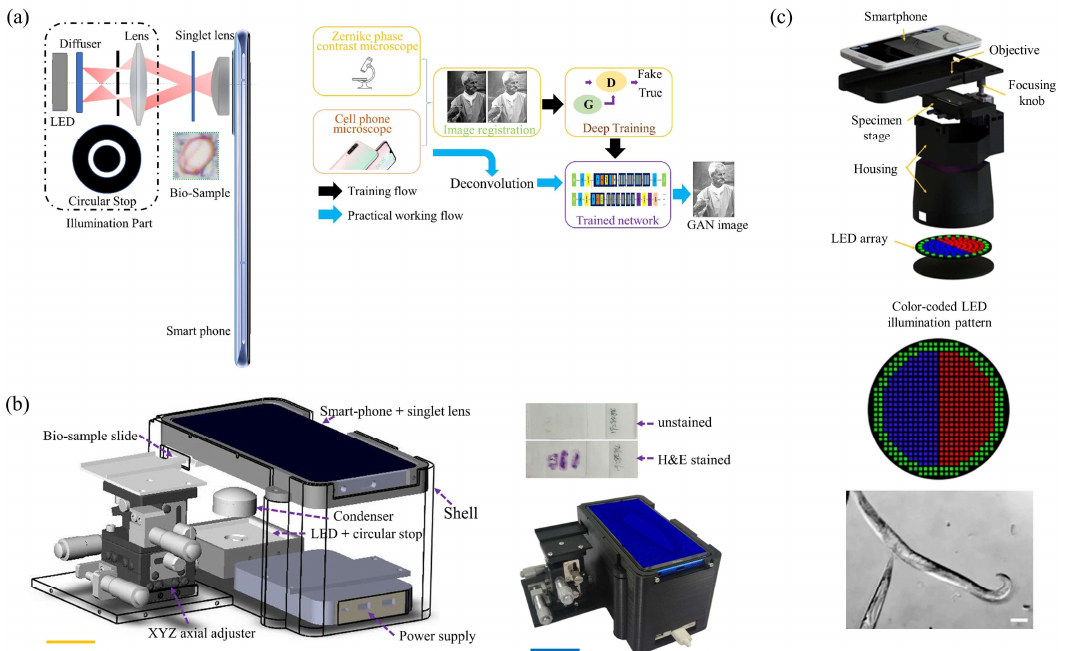
Figure 9. Smartphone-based phase contrast microscopy setups: ( a ) a 2D principle schematic based on a singlet objective and deep learning architecture for image enhancing [81]; ( b ) a 3D mechan- ical design [81]; ( c ) smartphone-based phase contrast microscope based on computational LED illumination